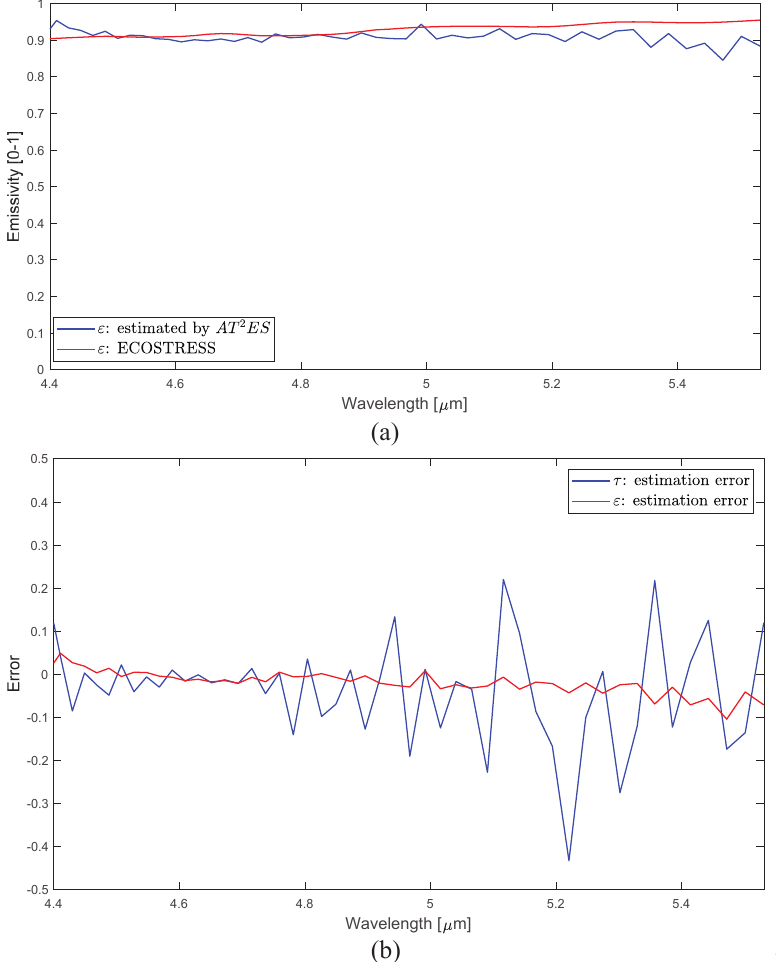
Figure 28. Asphalt region: Control of the emissivity offset by adding an object temperature offset: ( a ) spectral emissivity, and ( b ) estimation error in spectral atmospheric transmittance and